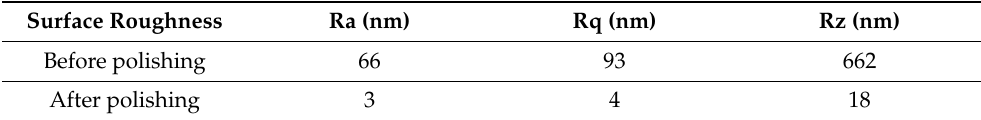
Table 2. Linear rugosity of the Ti-6Al-4V workpieces before and after polishing.